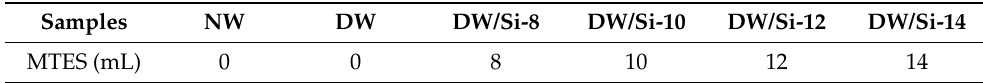
Table 1. The amount of silica source (MTES) in the